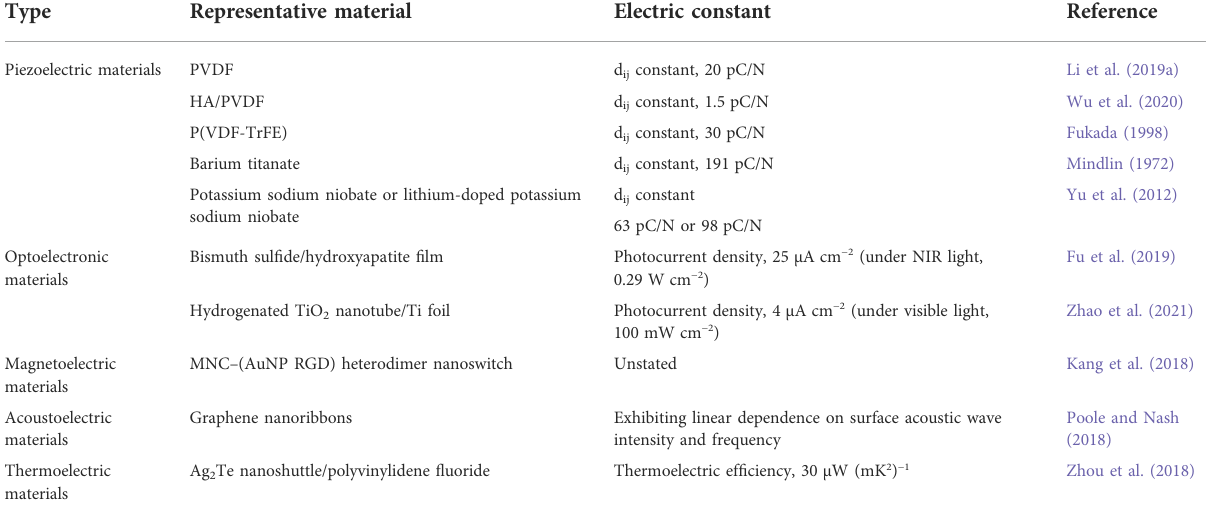
TABLE 1 Representative bio-reactive electrogenic materials and their electric